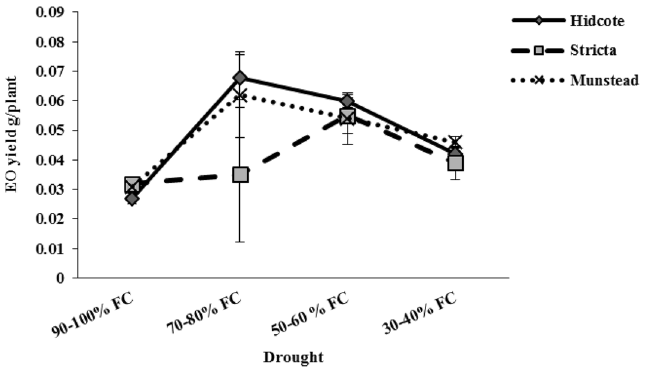
Figure 10. The effect of drought stress on essential oil yield in different lavender